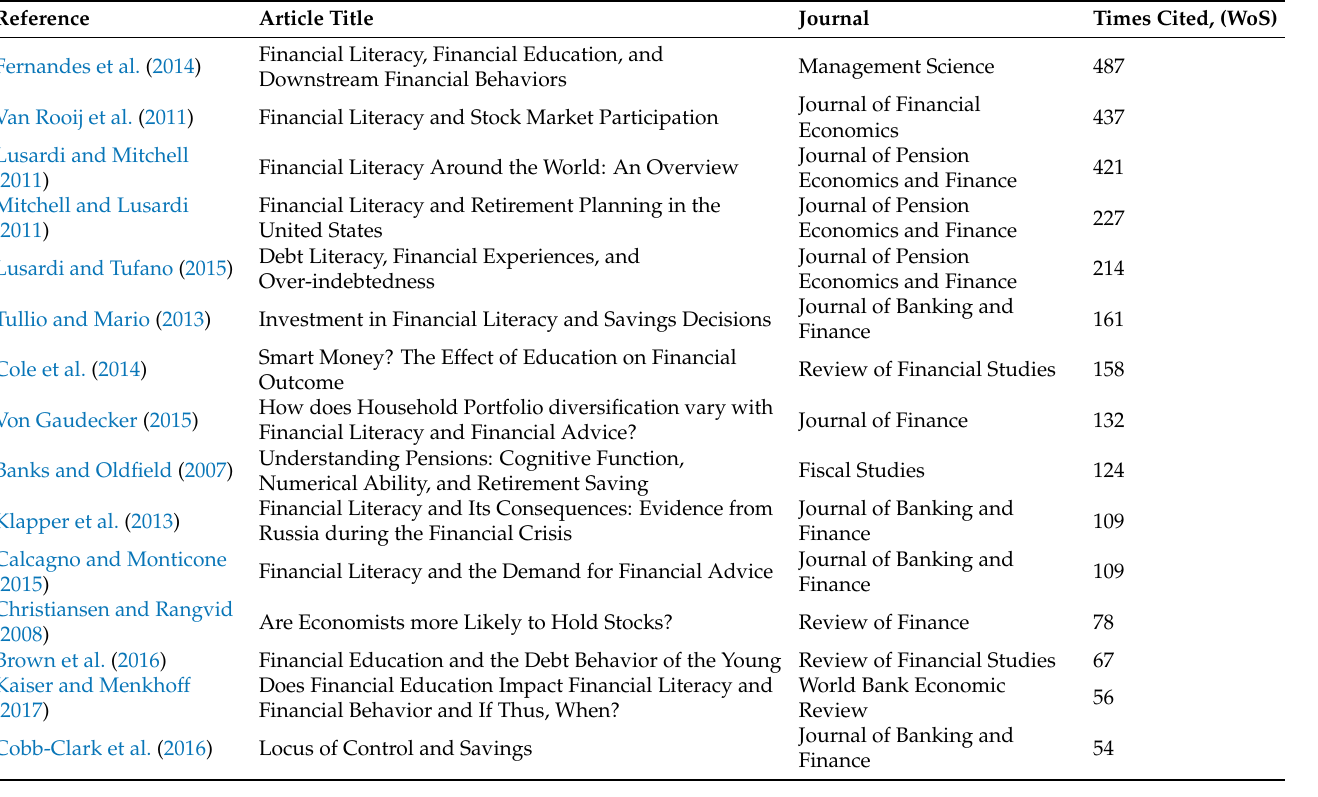
Table 3. Top publications based on citation count prepared using VOSviewer